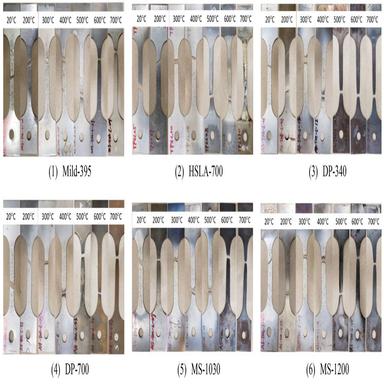
Failure modes of specimens in steady-state tests.